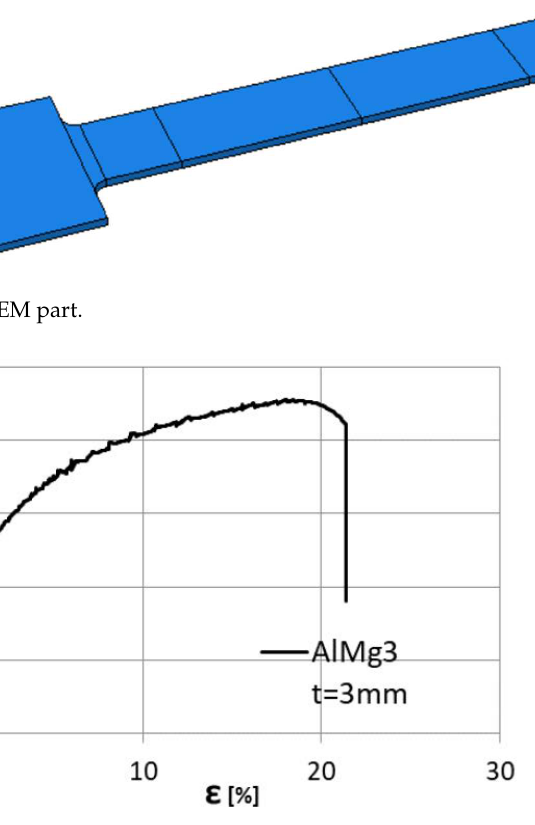
Figure 12. AlMg3 stress–strain curve.